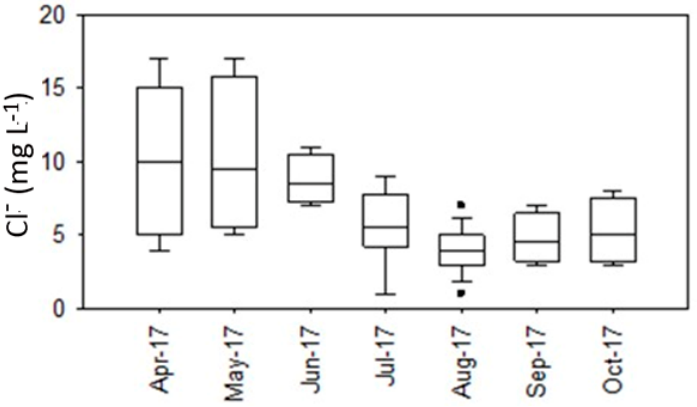
Figure 4. Boxplots of month chloride concentrations in precipitation in Dangishta in the 2017 rain phase. The dots placed above and below whiskers indicate outliers.